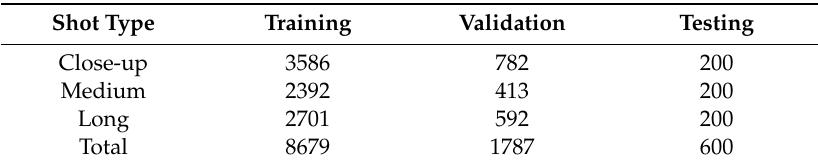
Table 1. Number of Frames.